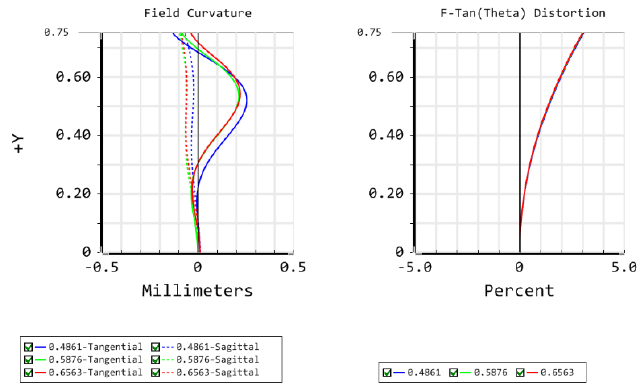
Figure 12. The field curvature and distortion of the Golay3 MMT.